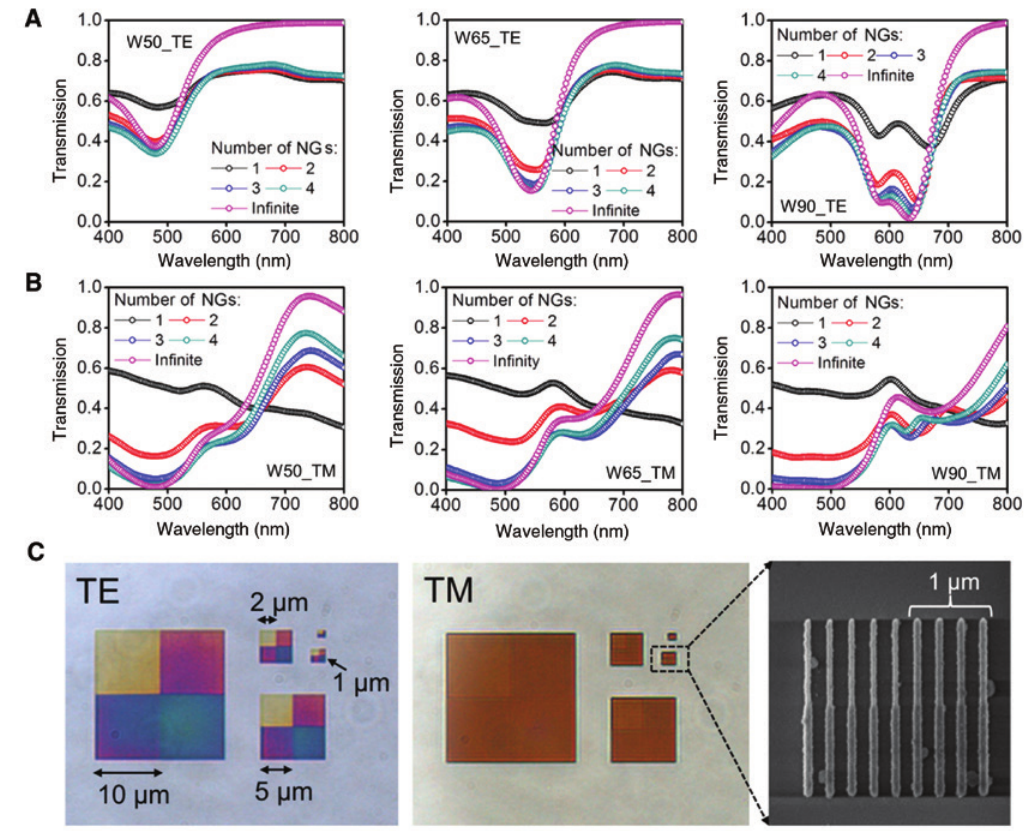
Figure 4: Realized high resolution of the proposed color pixels. The dependence of the simulated transmission spectra of the pixels with different NG widths of 50, 65 and 90 nm on the number of NGs under the (A) TE and (B) TM polarized illuminations. (C) The bright-field microscope images of the prepared samples having different pixel dimensions (10 μ m × 10 μ m, 5 μ m × 5 μ m, 2 μ m × 2 μ m, 1 μ m × 1 μ m and 0.5 μ m × 0.5 μ m). The SEM image taken from the sample with the pixel dimension of 1 μ m × 1 μ m is given on the